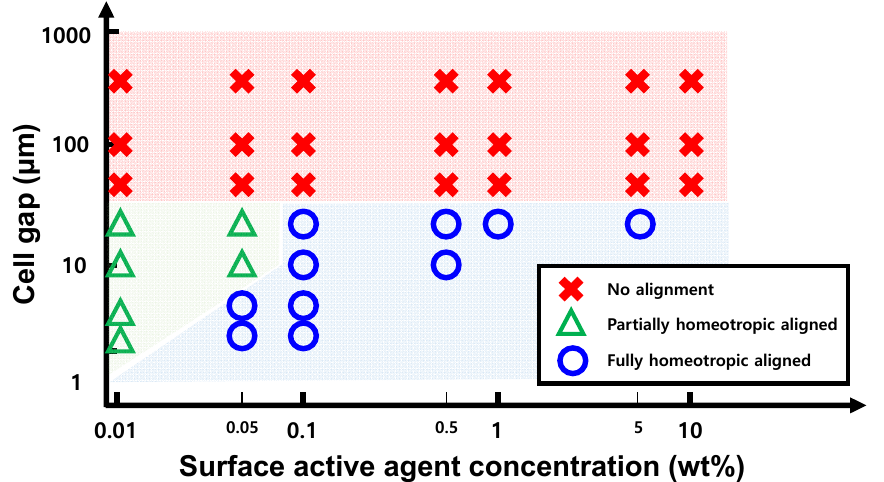
Figure 4. Diagram of alignment states vs. cell gap and surface-active agent concentration. ✕ : no alignment, ∆ : non-uniform homeotropic alignment caused by insufficient [HTAB], ◦ : fully-homeotropic alignment across the entire cell.